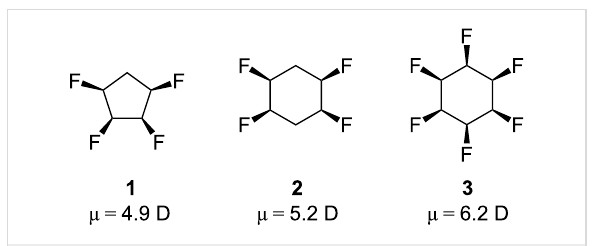
Figure 1: Selected fluorinated polar alicyclic